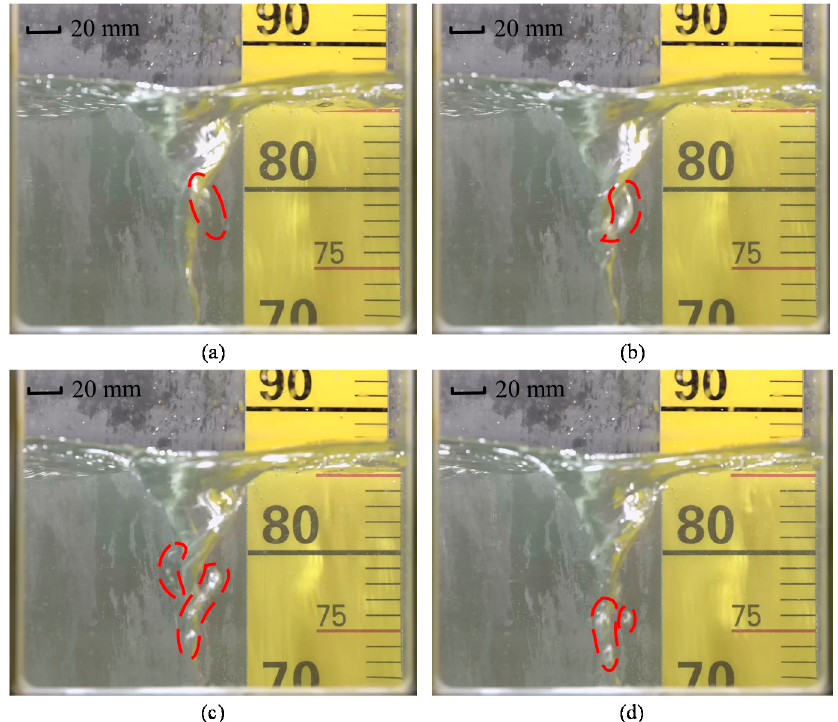
Figure 8. The process of free-surface vortex shedding air cores under centrifugal force in the primary Figure 8. is applied in the original experimental results; the identified experimental results (Figures pump intake. ( a ) The preliminary process of the air cluster; ( b , c ) the larger air clusters were then thrown 9b,d, and 11b) were obtained in MATLAB. First, the real-time experimental results were compared out of the main vortex rope and disintegrated; ( d ) the separated air fragments were all sucked into the with the background data (the water in the pump intake without pump running), and then the vortex next installations along with the free-surface vortex area was extracted. Then, the threshold method (each pixel is given a gray value of 0–255 degrees for recognition) was used to further identify the vortex area and its contour.